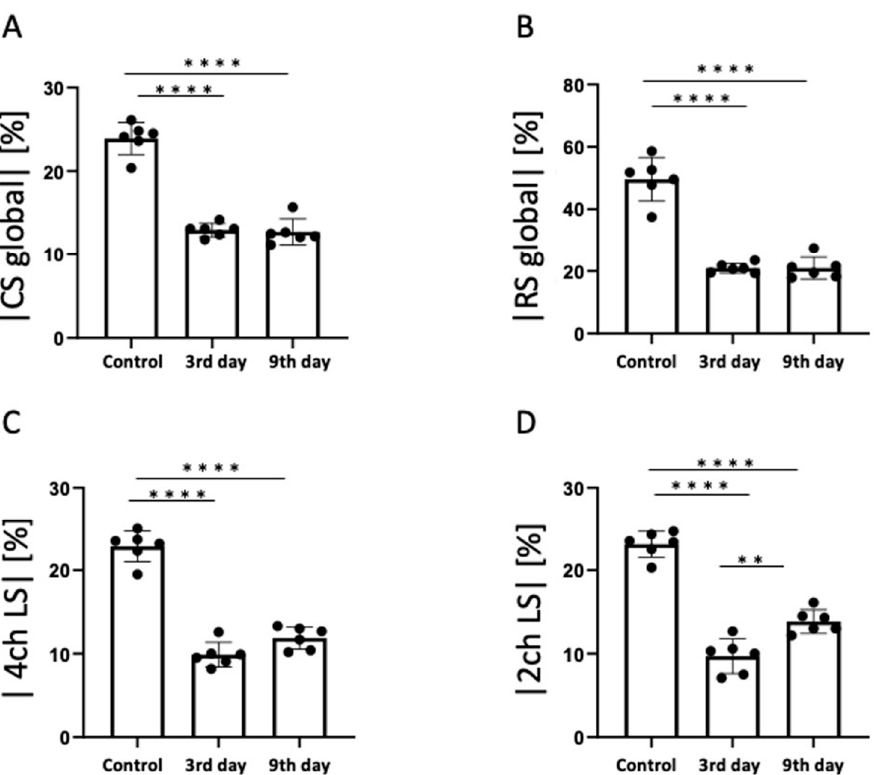
Figure 7. The results of statistical analysis of strain. ( A ) Global circumferential strain (CS), ( B ) Global radial strain (RS), ( C ) Four-chamber view longitudinal strain (4ch LS), ( D ) Two-chamber view longitudinal strain (2ch LS). ** p < 0.01, **** p < 0.0001.